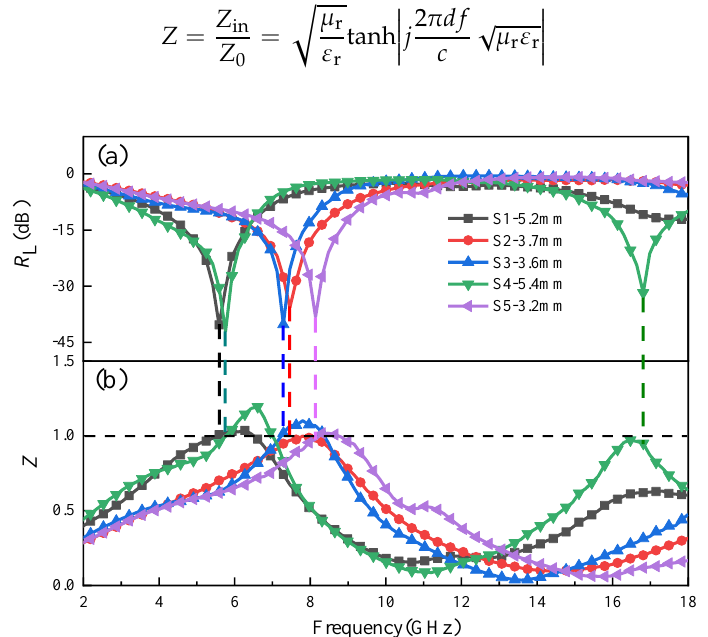
Figure 8. ( a ) The R L and ( b ) Z of Fe 3 O 4 samples at resonance thickness.